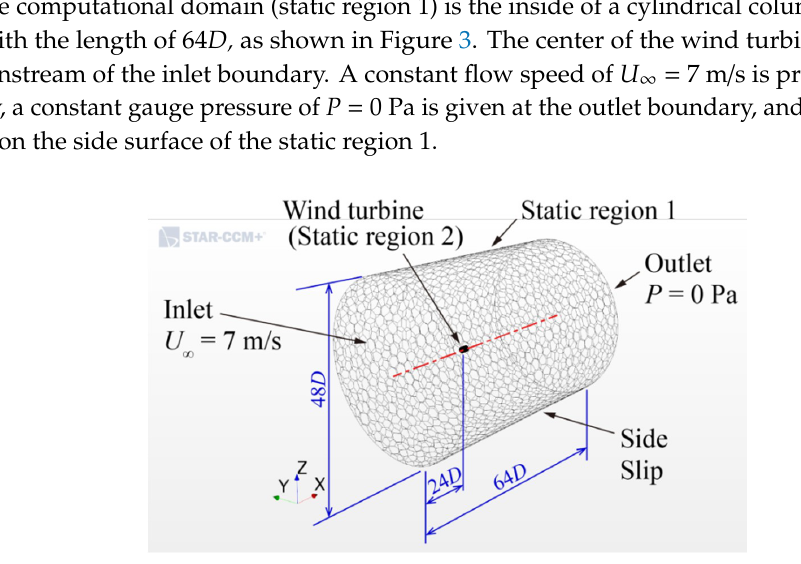
Figure 5. Mesh state around turbine blades on an equatorial plane. 2.2.2. Results of CFD Analysis Regarding the Rotor Performance The state of vortex shedding from each rotor at the end of 7 revolutions (time level: 5040) is depicted in Figure 6 with the Q -criterion (second invariant of velocity gradient) isosurfaces ( Q = 200 s −2 ) [30], on which the vorticity magnitude is expressed using color contour (see the Supplementary Material including the animations of vortex shedding). Figure 6d depicts the case of the armless rotor, in which strong arc-shaped tip vortices are shed from both ends of each blade when a blade passes through the upwind half of the rotor. Blade 2 is in the position of azimuth Ψ = 180° in Figure 6d; the almost uniform vertical vortex built by the dynamic stall [31] is shed from the trailing edge around the equator of Blade 2. In addition to the above-mentioned vortex, vortices are shed from the arms in the rotors equipped with arms in Figures 6a–c. Especially in the circular arm rotor shown in Figure 6c, the vortices that are related to the Karman vortex streets are shed in the wake of the arms. The vortex shedding from the trailing edge of each airfoil arm in Figure 6a, which is a small amount and hardly observable, should be attributed to the outflow of the boundary layer. As the vortex shedding from the blades are complicated in the rotors equipped with arms, the existence of the arms has a considerable influence on the flow field around the blades. As shown in Figures 6a and 6b, a loop- like vortex is shed from each of the junction parts of the airfoil and rectangular arm rotors. Judging